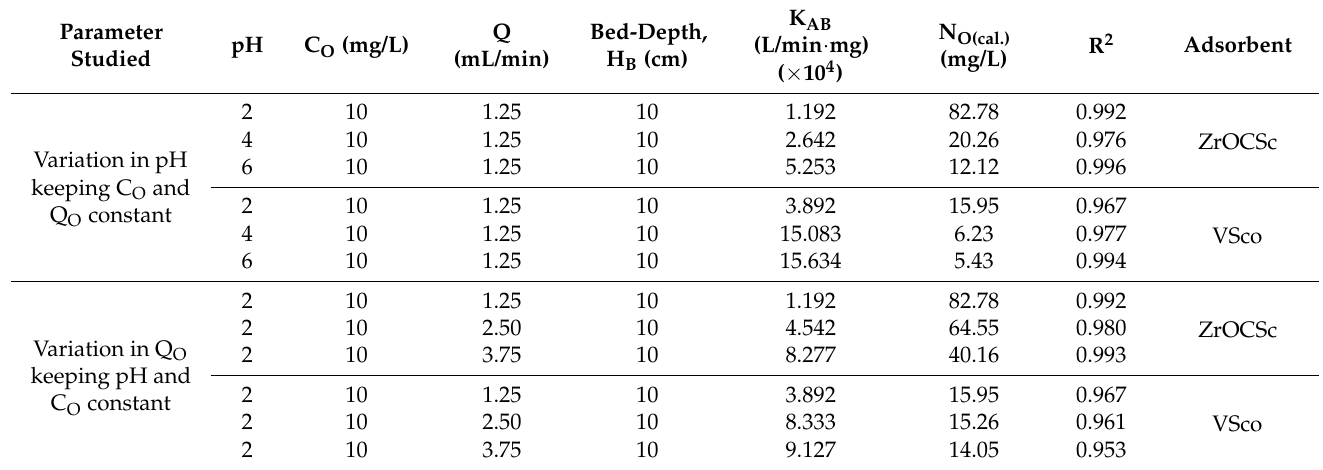
Figure 10. Experimental (exp.) and simulated (cal.; Adams–Bohart model) breakthrough curves of fluoride for VSco at different ( a ) pH (C O : 10 mg/L; Q O : 1.25 mL/min; bed depth 10 cm) and ( b ) Q O (pH 2; C O : 10 mg/L; bed depth 10 cm). Table 4. Adams–Bohart model parameter values for defluoridation by ZrOCSc and